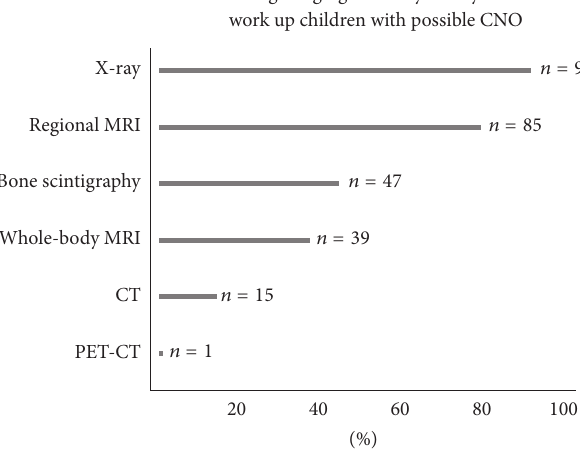
Figure 3: Imaging choices for suspected